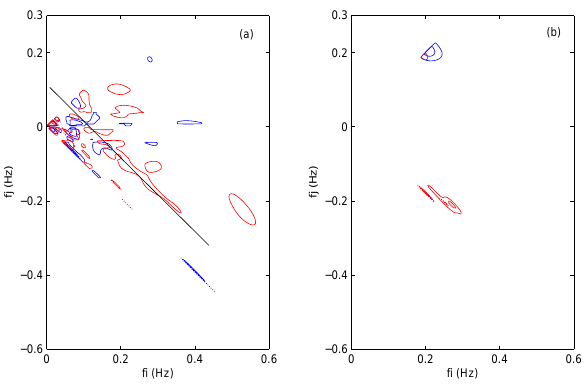
Fig. 8. Contours of (a) the wavelet bicoherence b 2 ηηη (contour lev- els: 0.45 and 0.8) and (b) the wavelet bispectrum B ηηη (contour lev- els: 0.8 and 0.9 times of the maximum value in stage I with extreme values at low frequencies eliminated) in stage I (blue contours) and stage II (red contours).